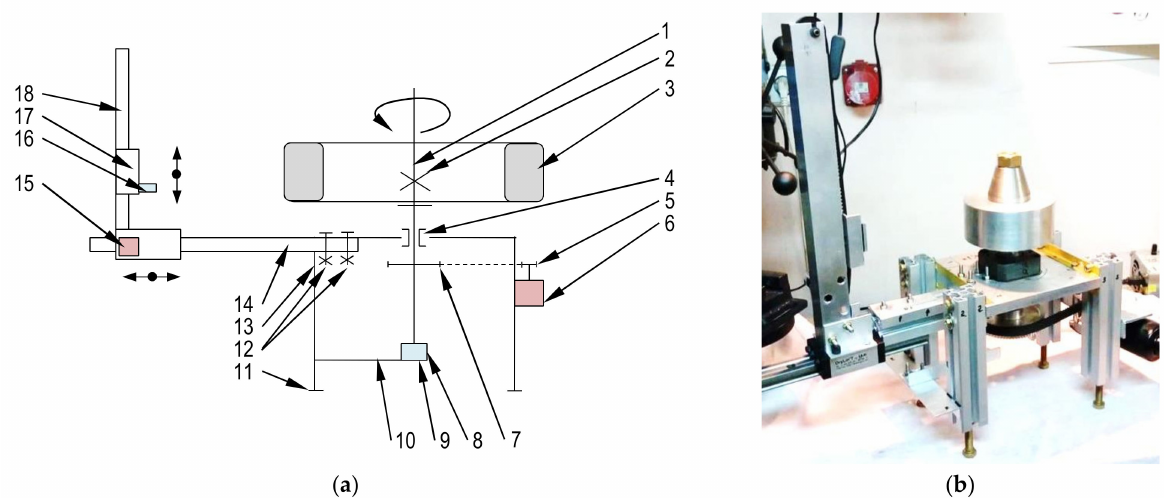
Figure 4. Original measurement device schematic ( a ). 1—main shaft, 2—fastening nut, 3-wheel, 4—bearing, 5,7—sprockets, 6—electric motor, 8—encoder, 9—encoder’s base plate, 10—arm, 11—foot, 12—locking screws, 13—leg, 14—guide, 15—electric motor, 16—sensor, 17—slide, 18—pol. ( b ) Original photo of measuring